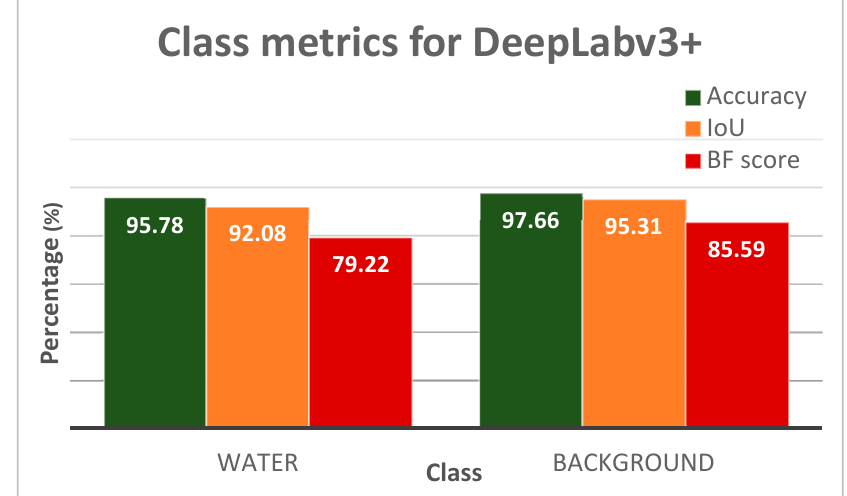
Figure 7. Class-specific metrics for DeepLabv3+ network.